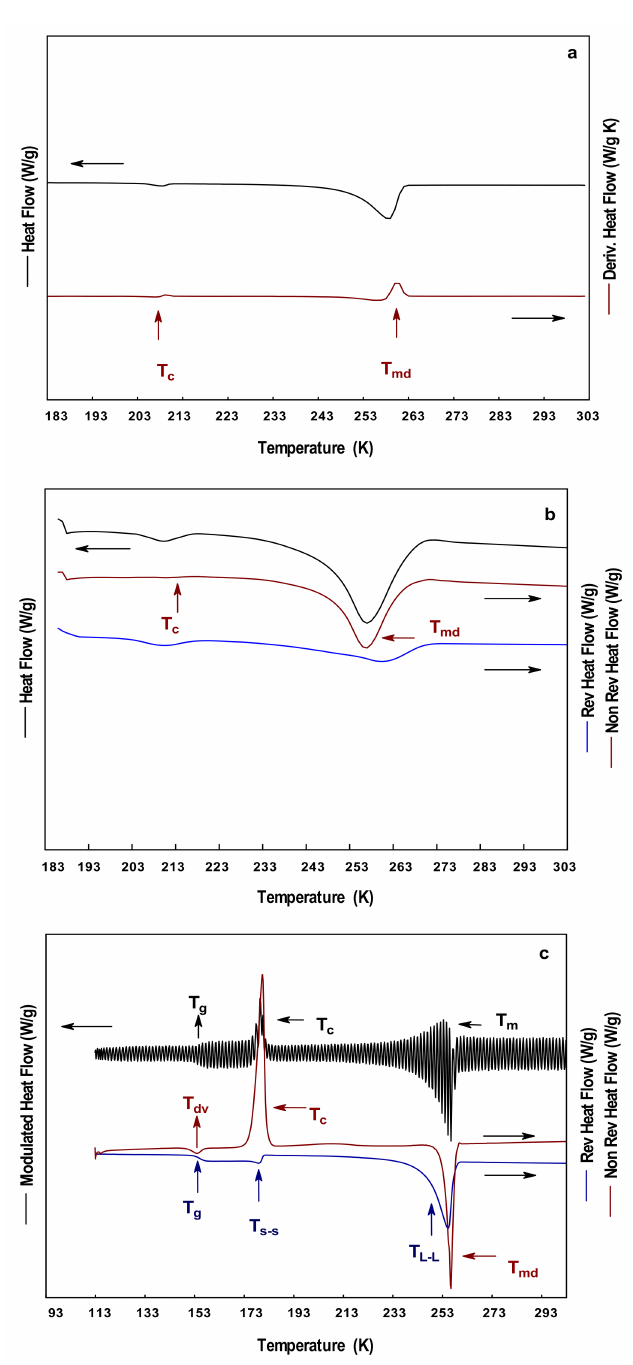
Figure 4. Thermograms of EG at 278 K/min: ( a ) DSC; ( b ) MDSC; and ( c )